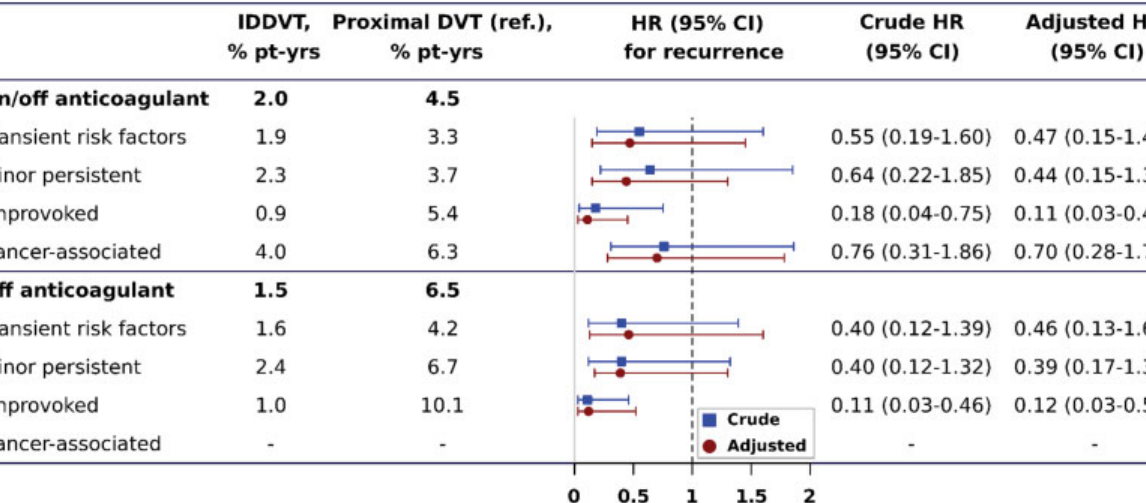
Fig. 1 Prognostic value of distal (vs. proximal) isolated deep vein thrombosis (DVT) according to baseline provoking risk factors. Rates and hazard ratios (HR) for cancer-associated DVT patients off anticoagulants were not calculated as the mortality rate was high and vast majority of them received extended anticoagulant treatment. Adjusted HRs account for age, sex, length of anticoagulant treatment (only for events on and off anticoagulant), in-hospital status at the time of DVT diagnosis. 19 CI, con fi dence interval; IDDVT, isolated distal deep vein